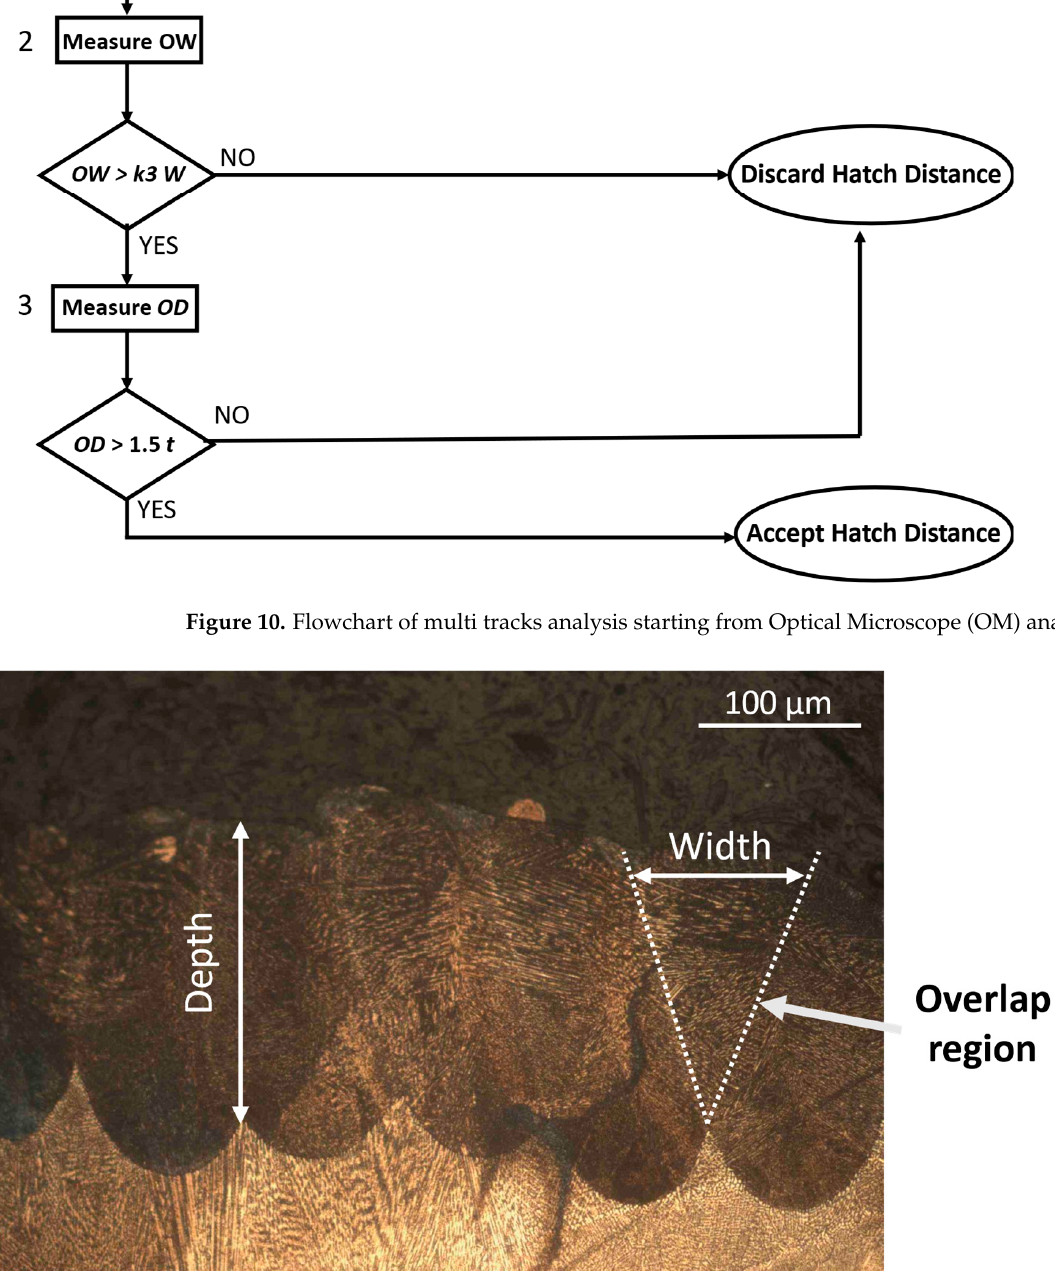
Table 1. Chemical composition of IN718. C